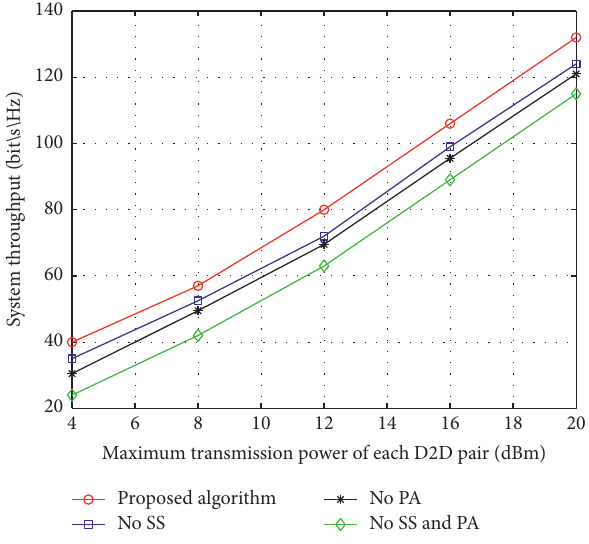
Figure 3: System sum rate for different maximum transmission power of each D2D